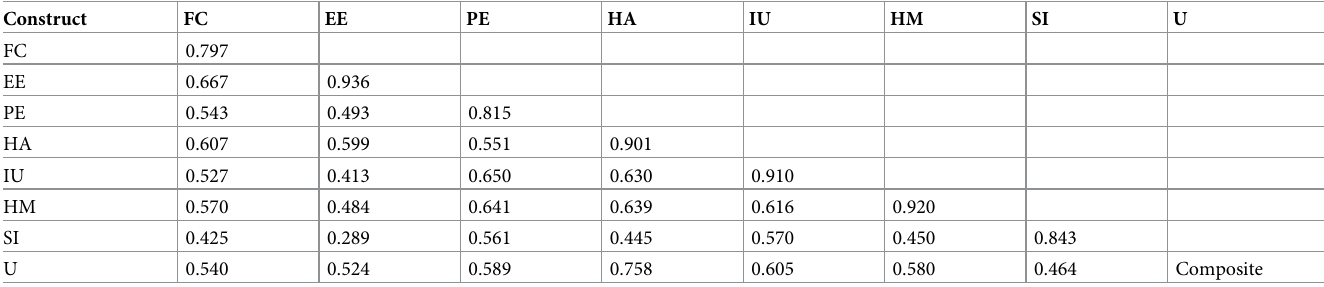
Table 5. Construct discriminant validity—Fornell-Larcker criterion.